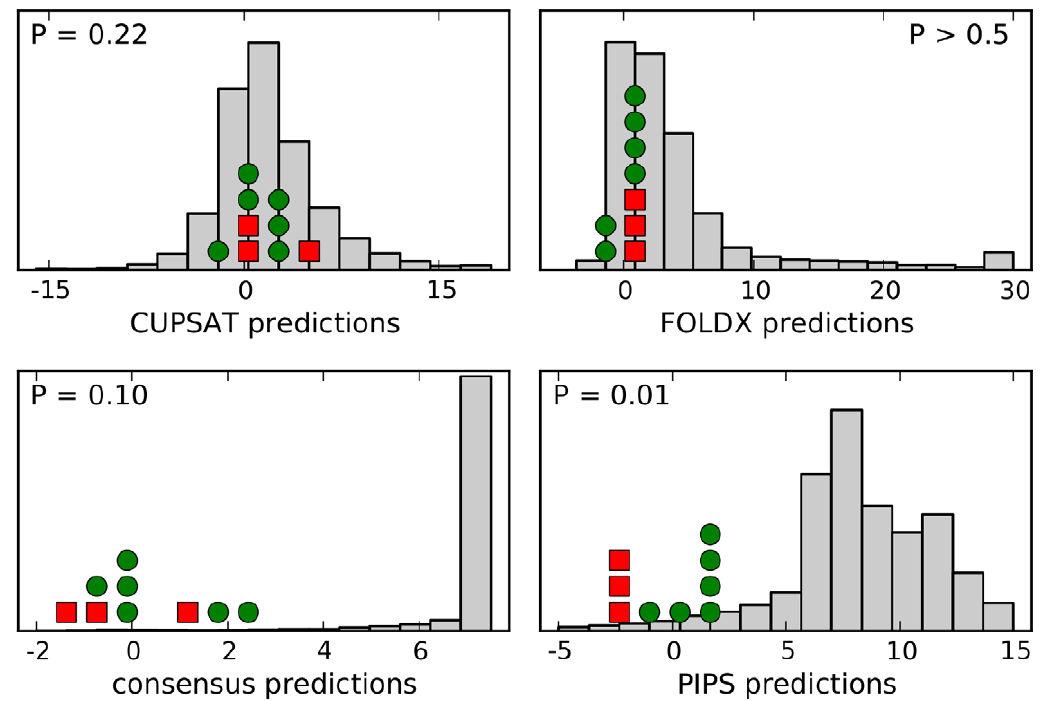
Figure 2. PIPS is the most effective computational approach for retrospectively identifying the secondary mutations that increased seasonal H1N1 neuraminidase surface expression and activity. The histograms show the distribution of predicted effects for all possible single amino-acid mutations to the A/New Caledonia/20/1999 neuraminidase, for each of the four computational approaches (CUPSAT, FOLDX, the consensus approach, and PIPS). The A/Brisbane/59/2007 strain contains nine mutations in the crystallized ectodomain portion of the neuraminidase relative to the A/New Caledonia/20/1999 strain. The three mutations that were experimentally show to enhance neuraminidase surface expression or activity (R222Q, V234M, and D344N) are indicated with red squares, while the other six mutations are indicated with green circles. The units for the different prediction methods are arbitrary, but in all cases more negative numbers correspond to mutations that are predicted to be more favorable. Shown are one-sided P -values for the hypothesis that the prediction method assigns more negative values to the known enhancing mutations (red squares) than the other six mutations (green circles), as determined using the Mann-Whitney test. The most successful computational approach appears to be PIPS, which correctly places all three red squares to the left of all six green circles.